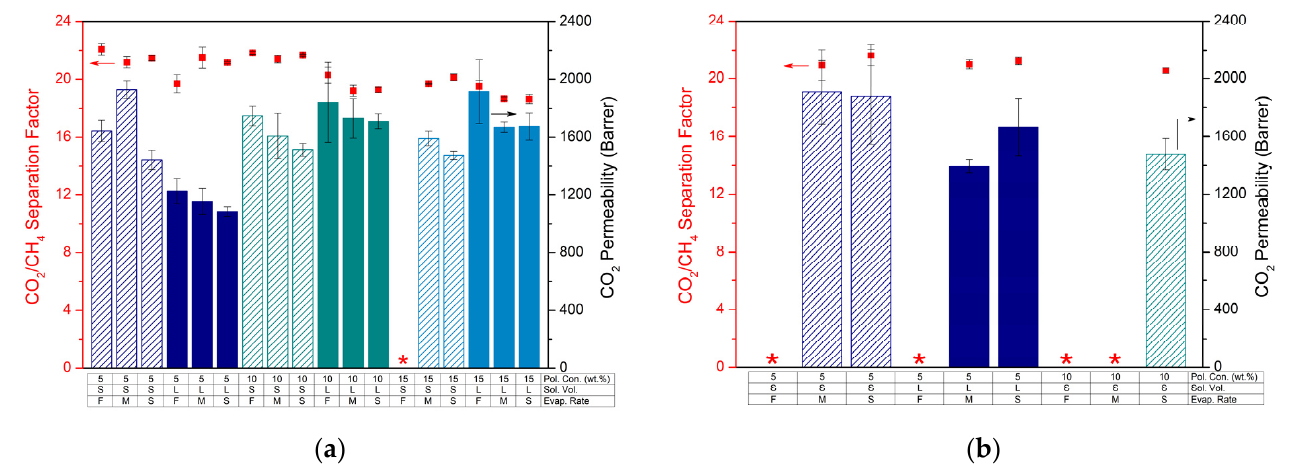
Figure 1. Mixed-gas CO 2 /CH 4 separation factors (dots) and CO 2 permeabilities (bars) of MOF-808/6FDD MMMs containing ( a ) 10 wt.% and ( b ) 30 wt.% filler, which were prepared under different synthesis conditions. “S” (“L”) implies the small (large) solution volume. “F” indicates fast evaporation, while “M” and “S” represent medium and slow evaporation rates, respectively. Red stars correspond to the membranes with no valid results due to the brittleness or defects.